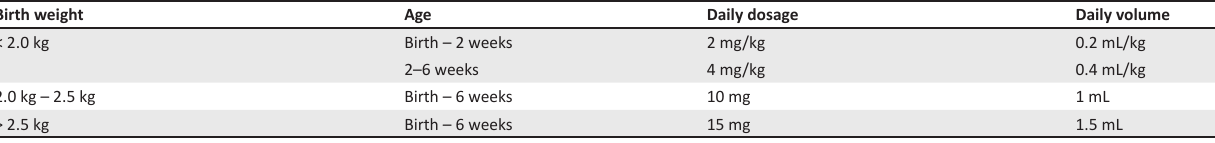
TABLE 1: Nevirapine doses for post-exposure prophylaxis in the first 6 weeks of life. Birth weight